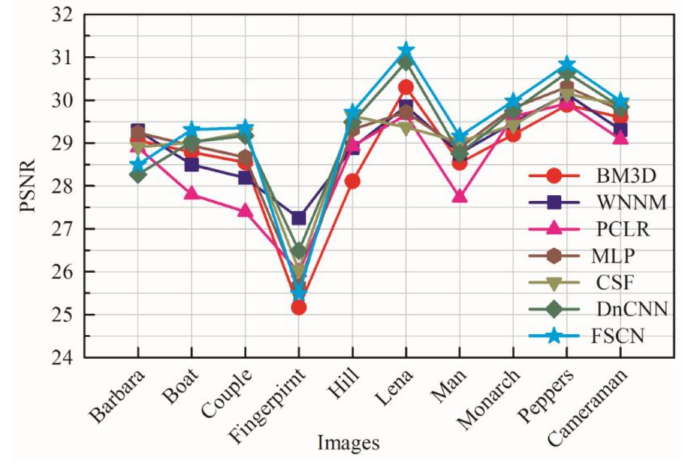
Figure 8. PSNR results on 10 images for σ = 0.09.